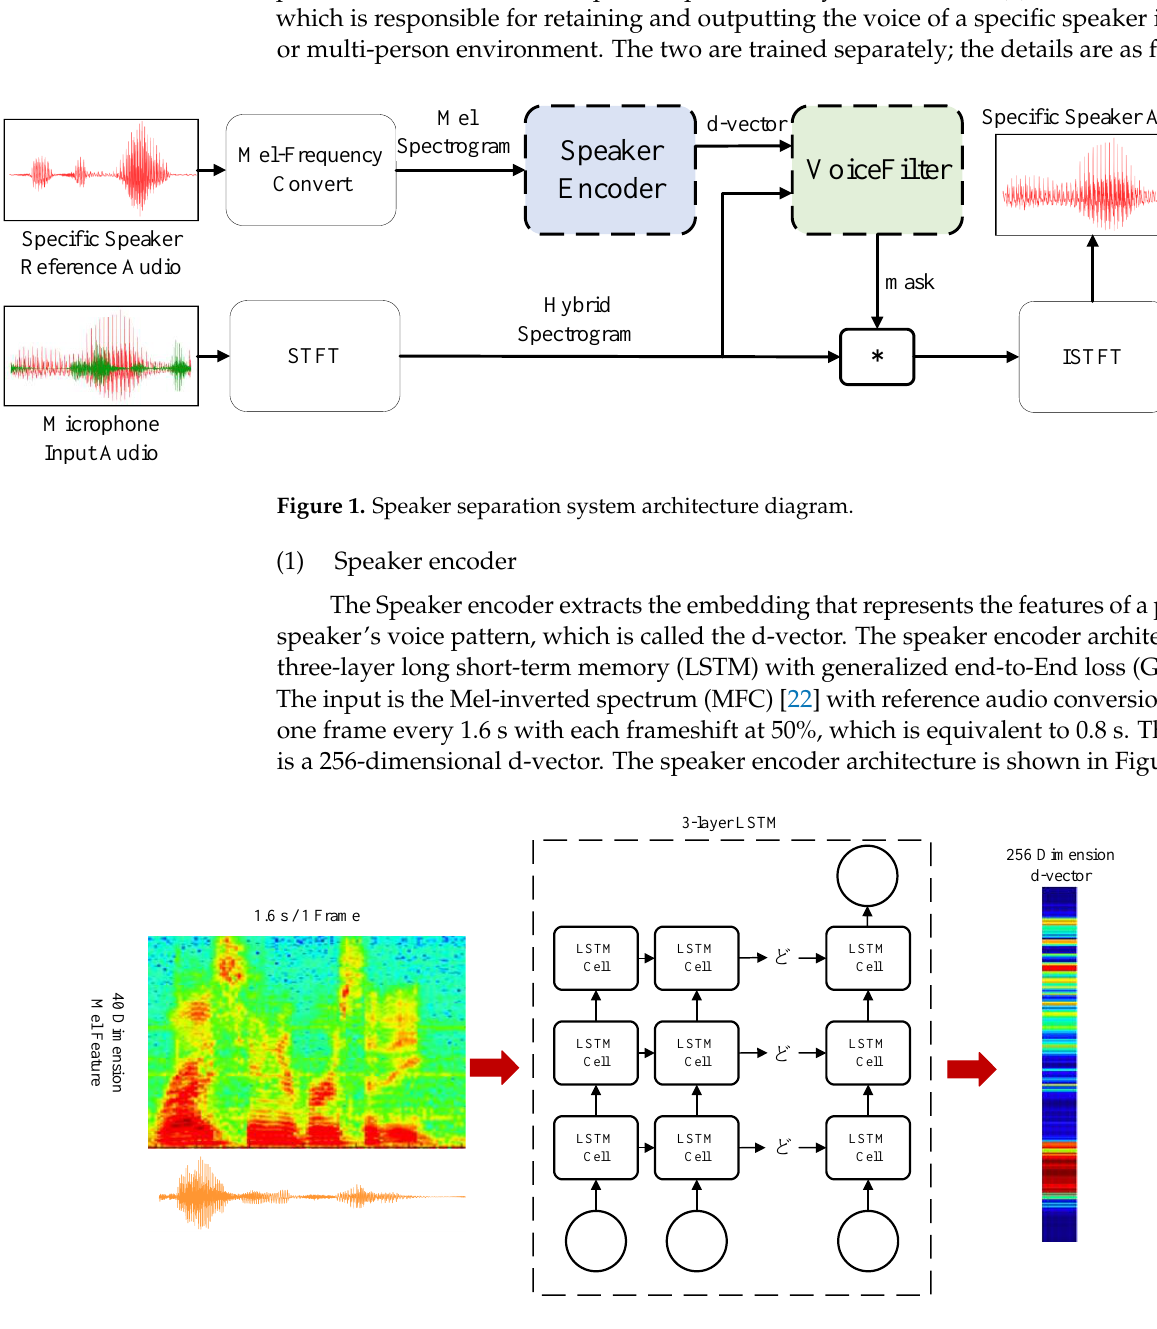
Figure 2. Speaker-Encoder Architecture Diagram.